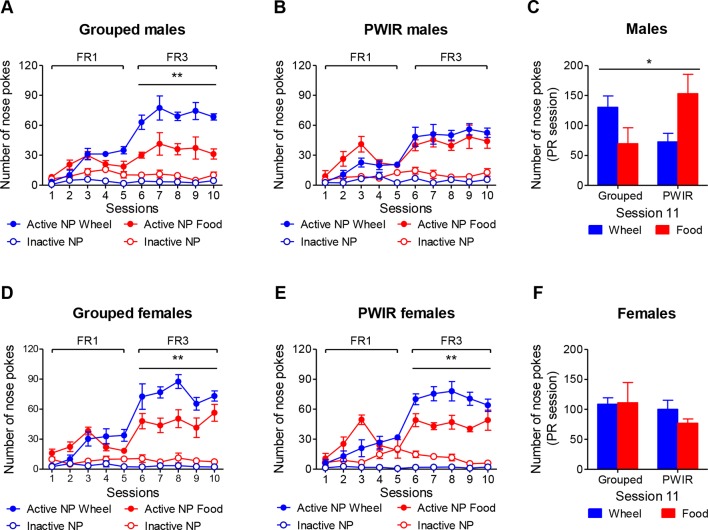
Sex-dependent effects of post-weaning isolation rearing (PWIR) on running motivation and palatable feeding motivation (each reward provided separately). (A,B) Grouped (A), but not PWIR (B), males displayed higher nose poke responses for wheel-running than for palatable food under FR3 schedules of reinforcement. (C) Grouped and PWIR male mice showed opposed profiles of nose poke responses for running and feeding during a PR session. (D,E) Both grouped (D) and PWIR (E) females displayed a higher number of nose poke responses for running, compared to feeding, under FR3 schedules of reinforcement. (F) Neither PWIR nor the reward nature exerted influences on the number of nose responses displayed by female mice for reward access during a PR session. The values are the mean ± standard error of the mean of n = 5–6 mice. * p < 0.05 for the PWIR × reward interaction during the PR session, and ** p < 0.01 for the overall difference between rewards under FR3 schedules of reinforcement (multiple-way analyses of variance).